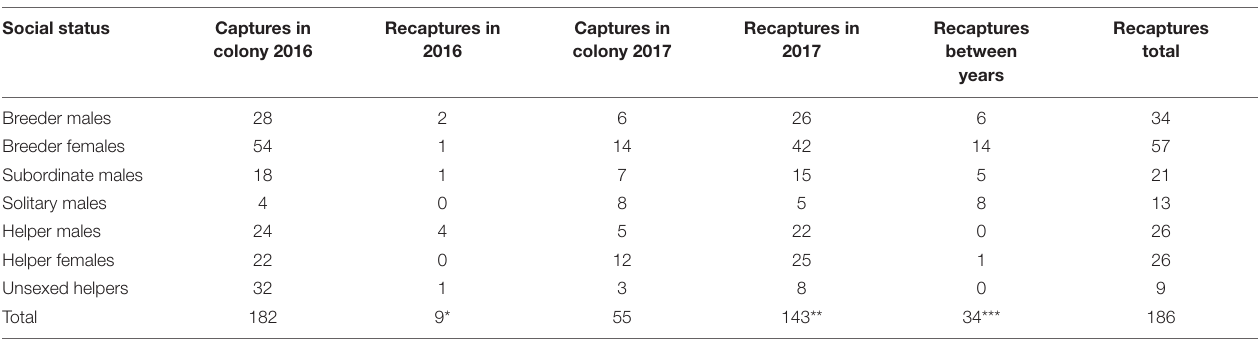
TABLE 1 | Total number of (re-)captured